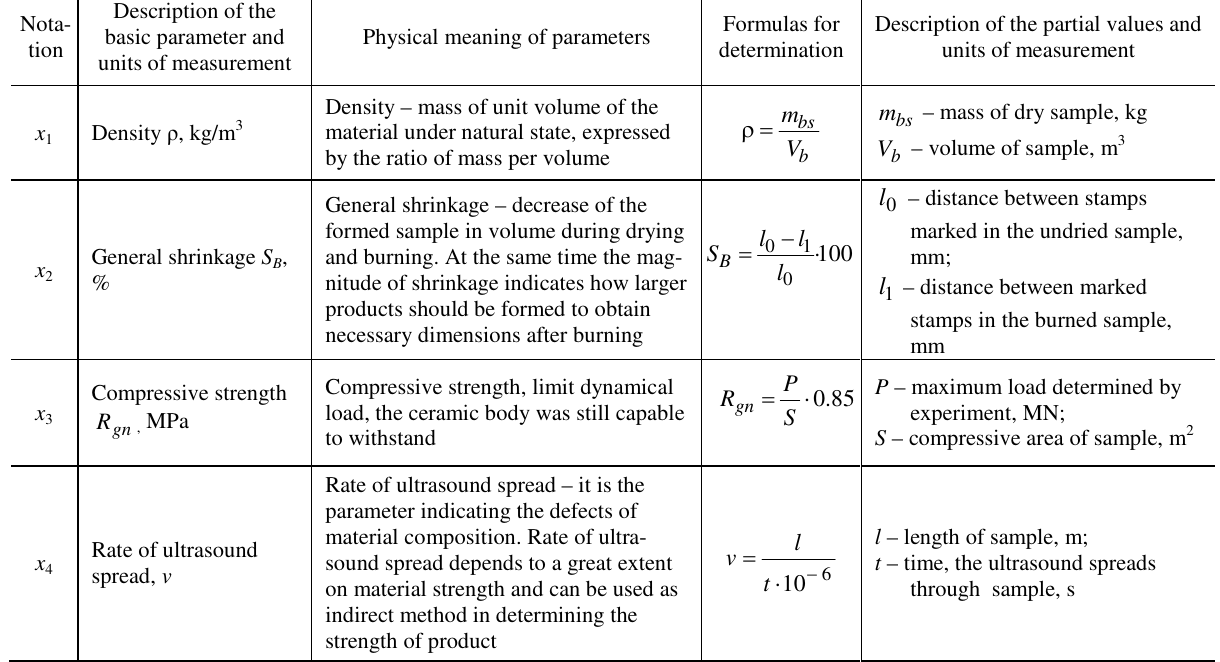
Table 3. The revised (Nagrockien ė et al. 2005; Mandeikyt ė , Šiau č i ū nas 1997; LST EN 771-1+A1 2005) methodology for calculation of physical and mechanical parameters Description of the Nota- tion